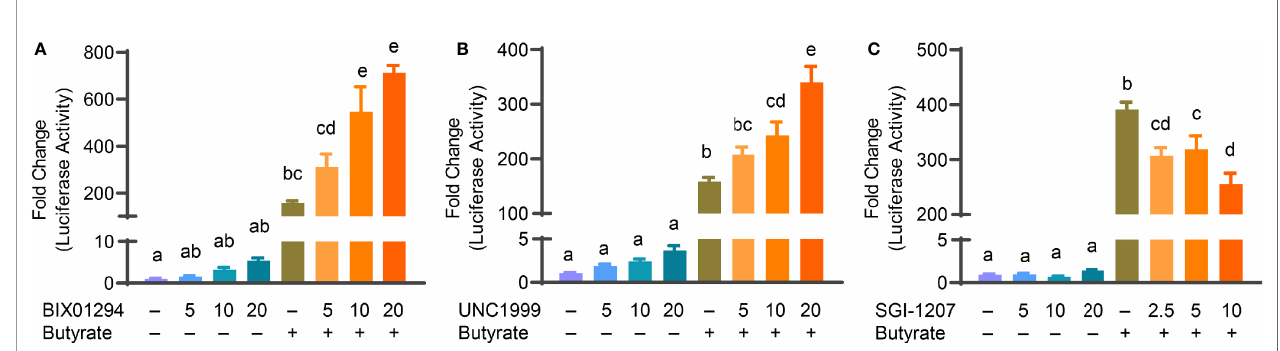
FIGURE 3 | Synergistic induction of luciferase activity in HTC/ AvBD9-luc cells between butyrate and an HMTi or a DNMTi. Chicken HTC/ AvBD9-luc luciferase reporter cells were stimulated in duplicate with indicated concentrations ( m M) of BIX01294 (A) , UNC1999 (B) , or SGI-1027 (C) individually or in combination with 2 mM butyrate for 24 h, followed by luciferase assay for the AvBD9 gene promoter activity. Results are shown as means ± SEM of three independent experiments. The bars not sharing a common superscript are considered signi fi cantly different ( P < 0.05) based on one-way analysis of variance and post hoc Tukey ’ s test.